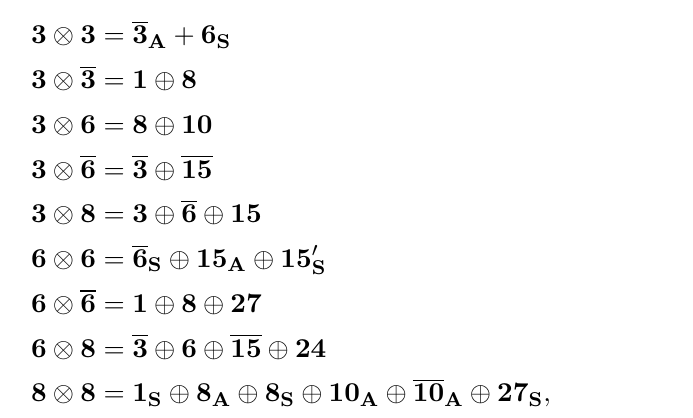
Table 2 . (cid:11) Q coe(cid:14)cients for the decomposition of the Coulomb potential described in equation (B.2) for di(cid:11)erent SU (3) representations of the particle-antiparticle pair in the initial state. of all the possible pairs of colored initial states that can annihilate into colored SM parti- cles. All the relevant initial state color combinations for either self-annihilation or mixed annihilation processes